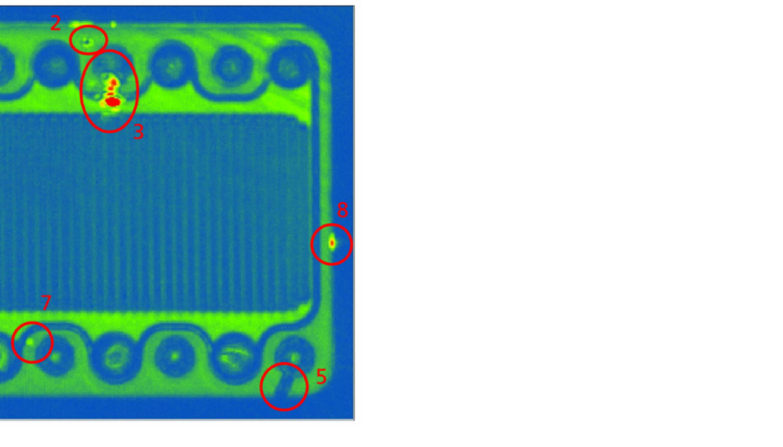
Figure 7. C-scan image of a cell element obtained by air-coupled ultrasound with internal defects as shown in Figure 4.